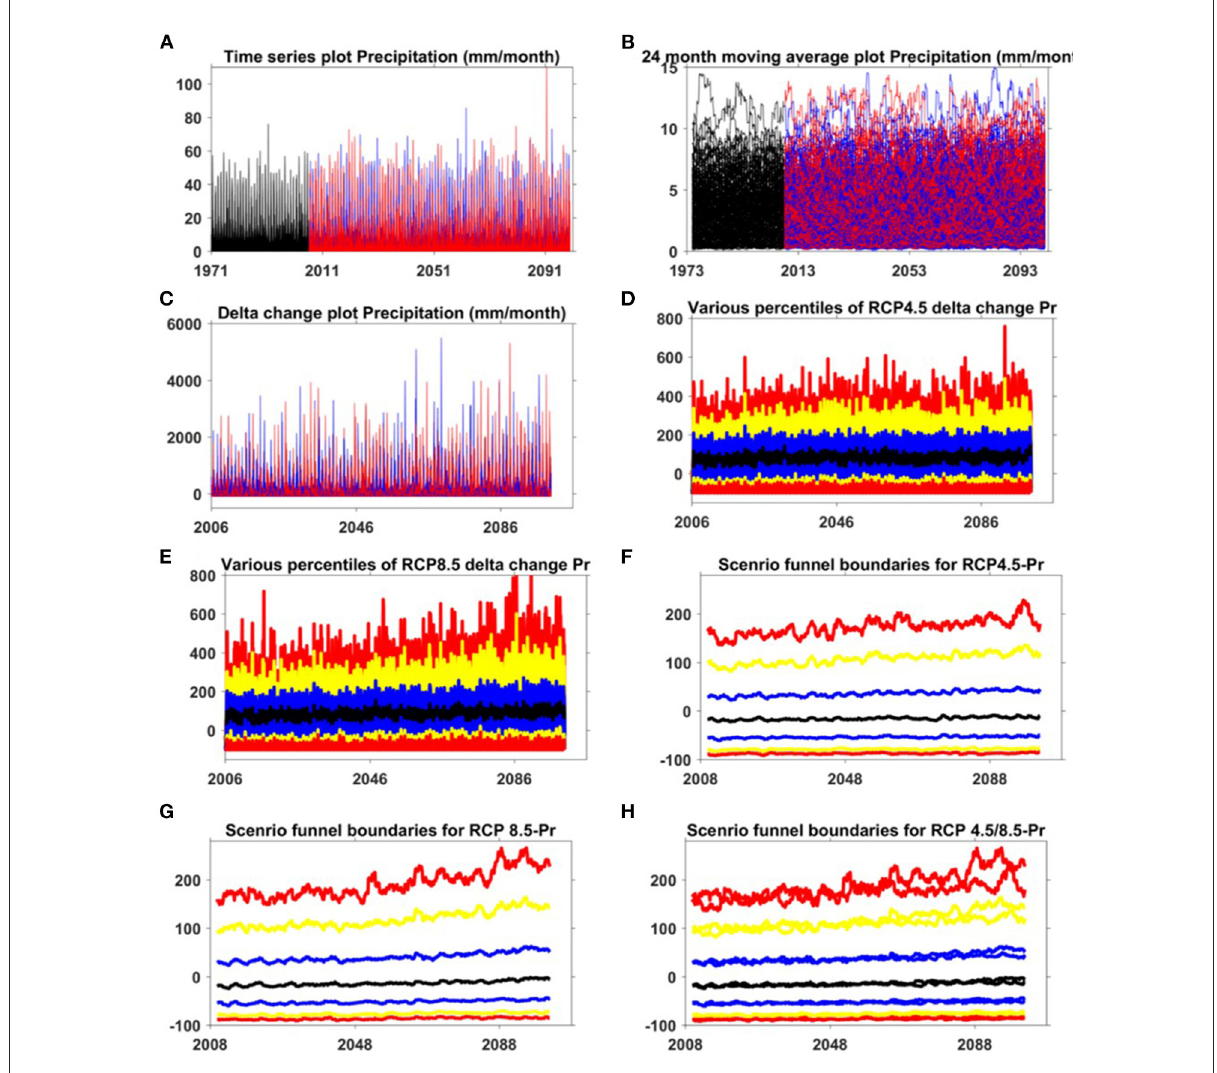
FIGURE3 The plot of various steps in developing the scenario funnel for precipitation [Pr, (A–H) ] by data-analysis, (A) time-series plot of raw precipitation data, (B) time-series plot of 24 month moving average precipitation data, (C) time-series plot of delta change estimated for precipitation, (D) various percentile values for RCP 4.5 for precipitation (red: 5th, 95th; yellow:10th, 90th, blue: 25th, 75th, black: 50th percentiles), (E) various percentile values for RCP 8.5 for precipitation (red: 5th, 95th; yellow:10th, 90th, blue: 25th, 75th, black: 50th percentiles), (F) Developing scenario funnel boundaries for RCP 4.5 from 24 month moving average of the percentiles (red: 5th, 95th; yellow:10th, 90th, blue: 25th, 75th, black: 50th percentiles), (G) Developing scenario funnel boundaries for RCP 8.5 from 24 month moving average of the percentiles (red: 5th, 95th; yellow:10th, 90th, blue: 25th, 75th, black: 50th percentiles), (H) scenario funnels for precipitation. In (A–C) , red and blue color represents the RCP 8.5 and RCP 4.5, respectively. (For interpretation of the references to color in this figure legend, the reader is referred to the web version of this